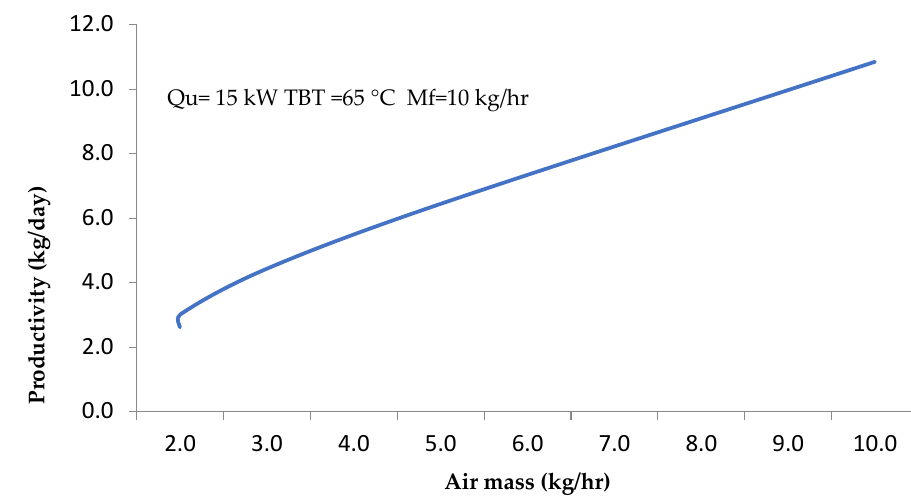
Figure 9. Effect of air mass flow rate on the freshwater productivity of the system.